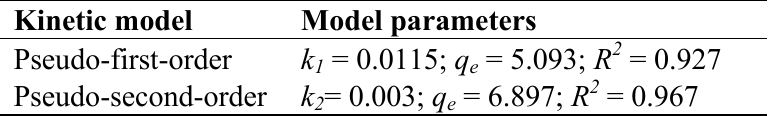
Table 2. Kinetic parameters for the adsorption of mogroside V on HZ 806 at 25